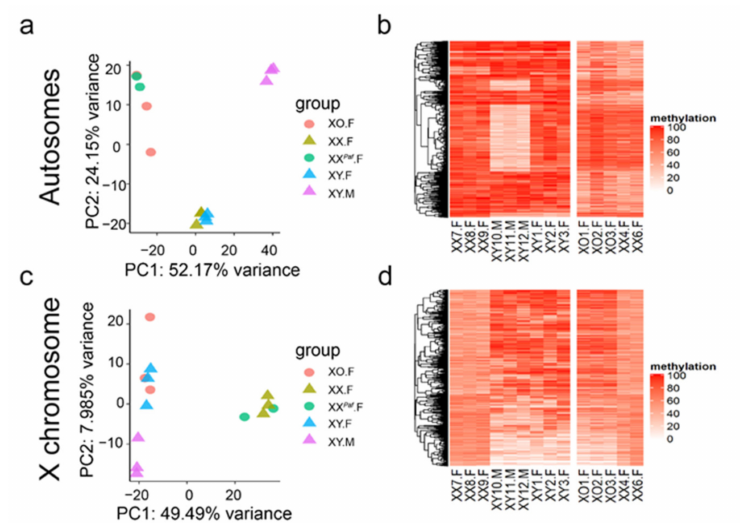
Figure 1. Sex phenotype, sex-chromosome complement, and genetic background influence methylation levels. ( a , b ) Principal component analysis (PCA) plot and heatmap show differential methylation across 2500 autosomal CpG sites with the largest variance in methylation. ( a ) Samples form clusters by phenotypic sex and genetic backgrounds of strain crosses. ( b ) Heatmap shows methylation levels of CpG sites for samples from theTIR and Paf crosses separately. The generated clustering dendrogram is then used to guide plotting the heatmap for the Paf cross. ( c , d ) PCA plot and heatmap show differential methylation across 2500 X-linked CpG sites with the largest variance in methylation. ( c ) Samples form clusters by number of X chromosomes and phenotypic sex. ( d ) Heatmap shows methylation levels of CpG sites for samples from the TIR and Paf crosses separately. Higher color intensity represents higher methylation